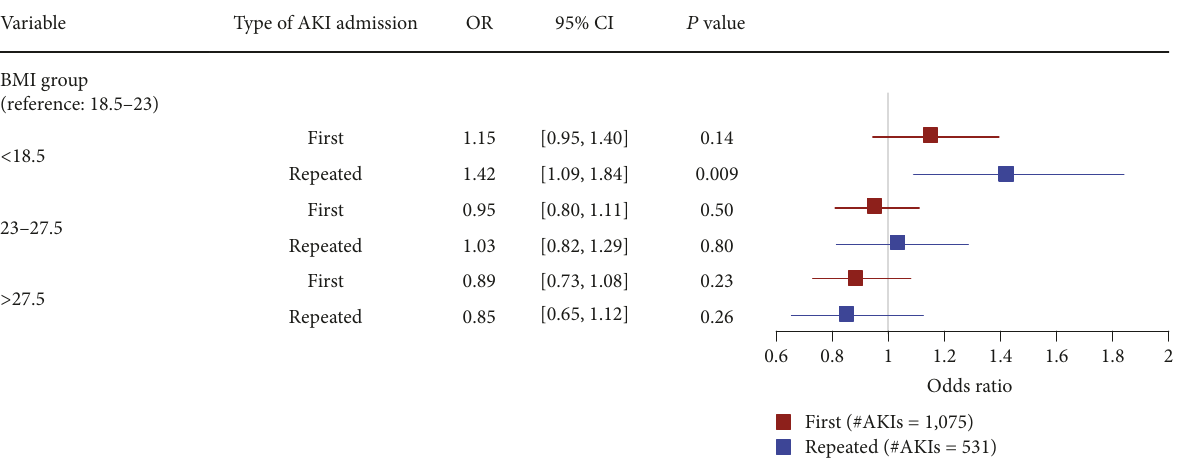
Figure 5: Multivariate logistic regression models for studying the relationship between BMI and acute kidney injury at their first (number of patients with acute kidney injury [#AKIs] = 1075) and repeated (number of patients with no acute kidney injury [#AKIs] = 531) admissions during the 12-month cohort period. Note . BMI: body mass index; CI: confidence interval; OR: odds ratio. Adjusted variables in logistic regression models include age, gender, ethnicity, background diagnoses (cardiovascular disease, chronic kidney disease, diabetes mellitus, hepatobiliary disease, psychiatric illness, and gastrointestinal disease), primary diagnoses (infectious and parasitic diseases, neoplasm, diseases of the genitourinary system, diseases of the musculoskeletal system and connective tissue, and symptoms, signs, and ill-defined conditions), and procedures (otolaryngology related surgery, endoscopy, open laparotomy, and cardiology related percutaneous